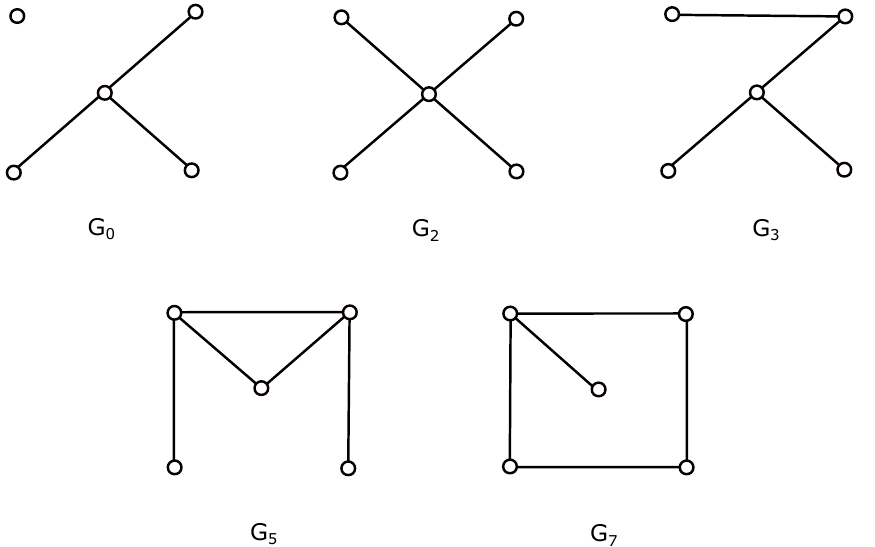
Figure 1. Planar drawings of five graphs G 0 , G 2 , G 3 , G 5 , and G 7 , which are subgraphs of the graph G 11